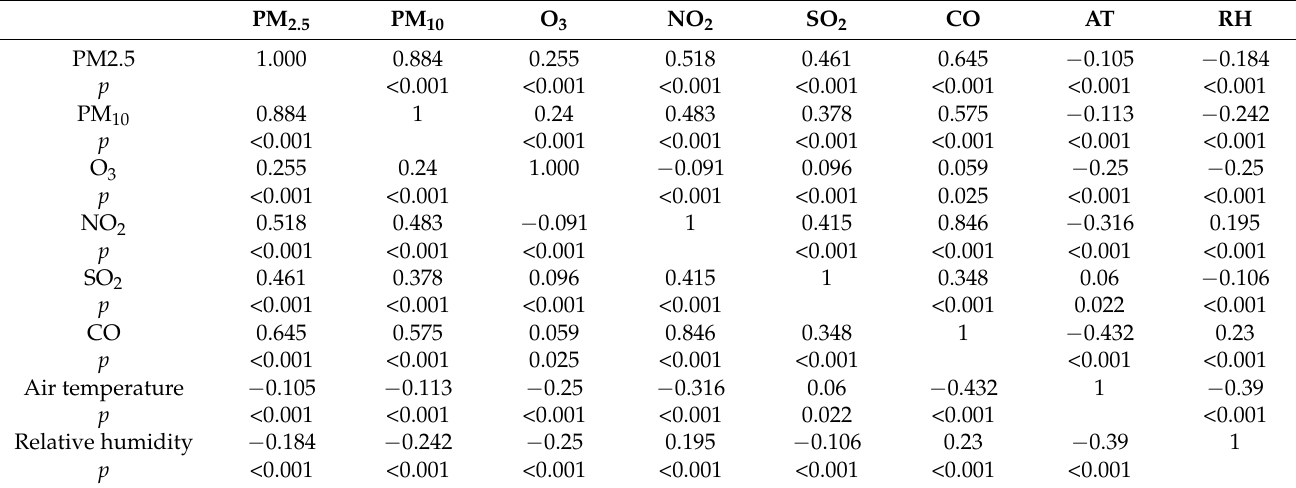
Table 2. The correlation between air pollutants and climate